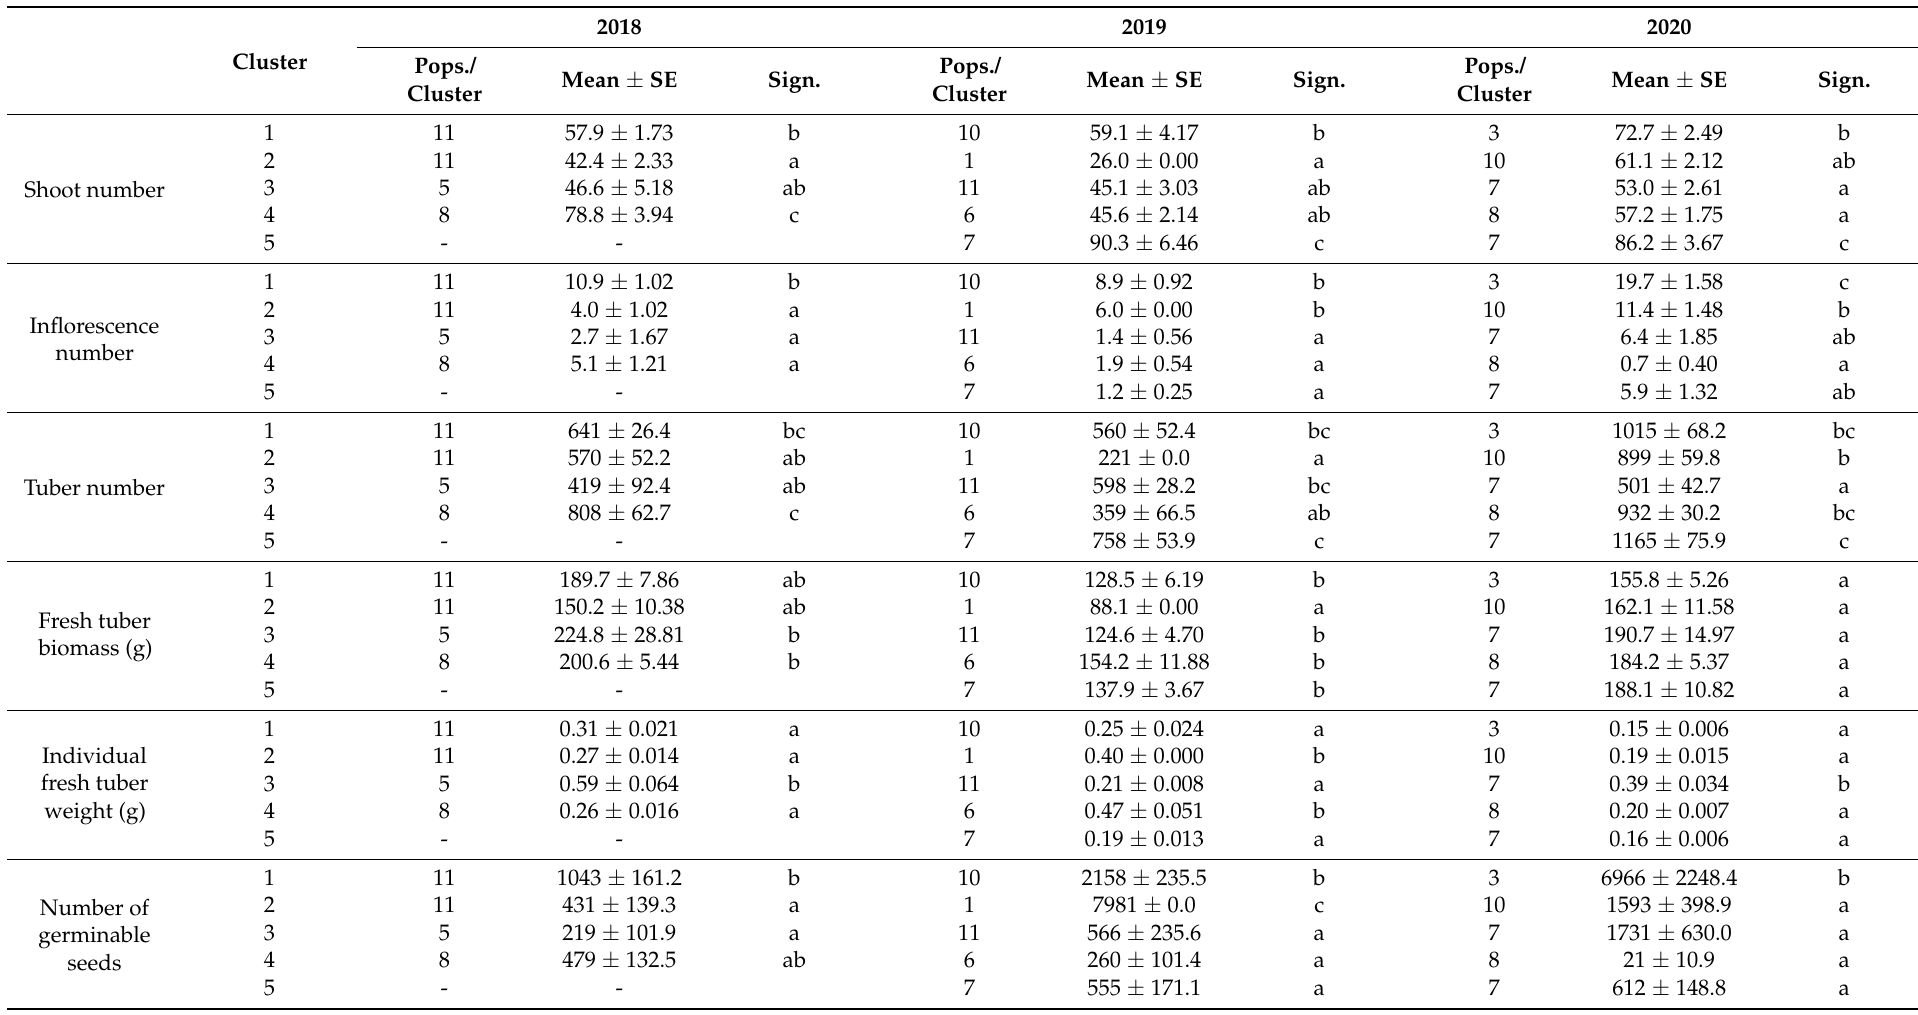
Table 4. Cluster code number of C. esculentus clonal populations, clonal populations per cluster, mean ± SE for the morphological variables measured per pot,